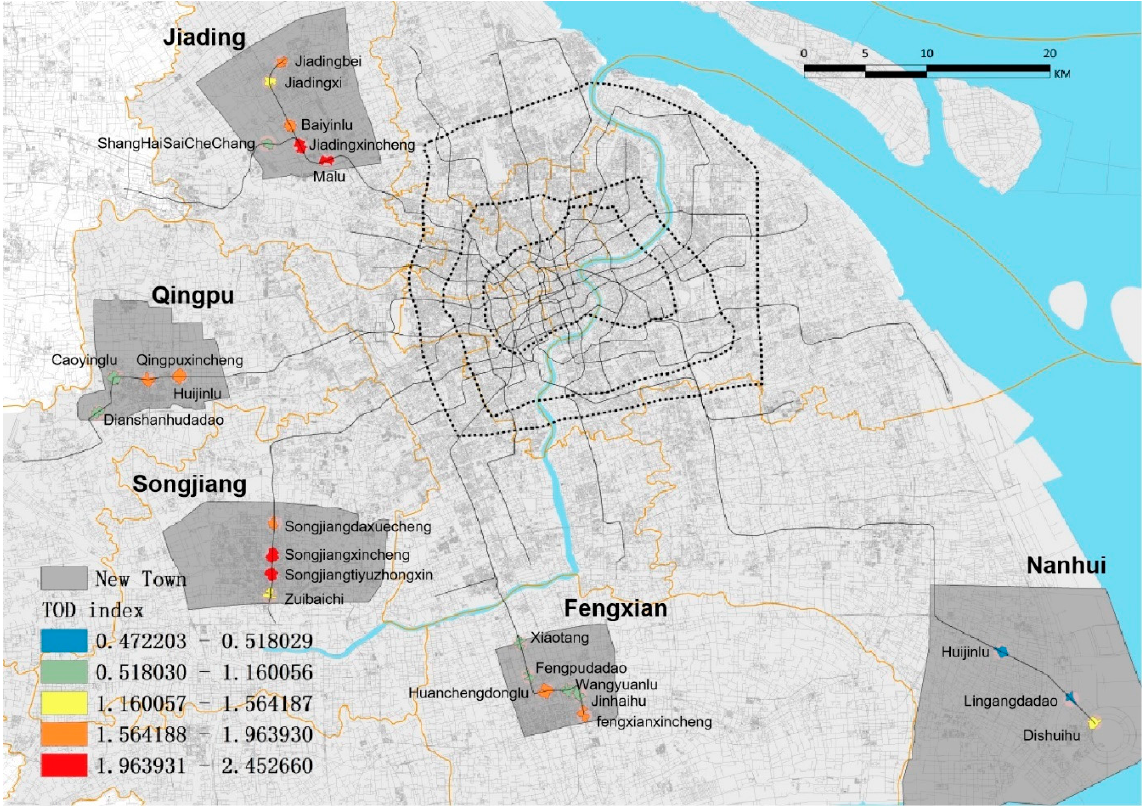
Figure 7. The spatial distribution of metro stations regarding their TOD indices.